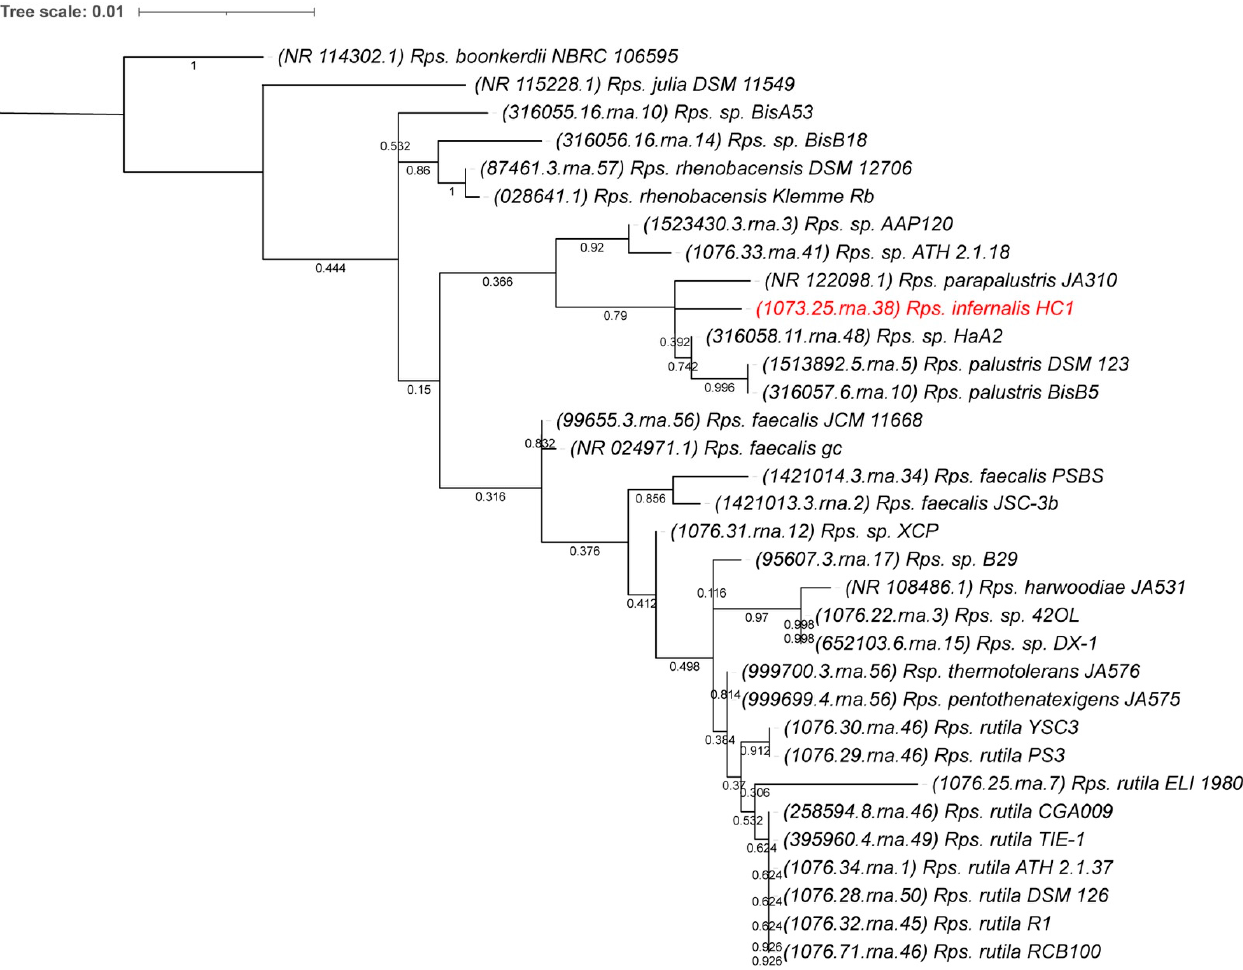
Figure 3. 16S rRNA ‐ derived phylogenetic tree for Rhodopseudomonas species. The phylogenetic tree was calculated in MegaX and iTOL was used to draw the phylogenetic trees expressed in the Newick phylogenetic tree format. Bootstrap values were generated from 500 bootstrapping rounds. The new isolate, Rps. infernalis HC1, 16 rRNA is indicated in red. Accession numbers from either NCBI Genbank or BV ‐ BRC numbers from genome ‐ derived sequences, are indicated in parentheses.